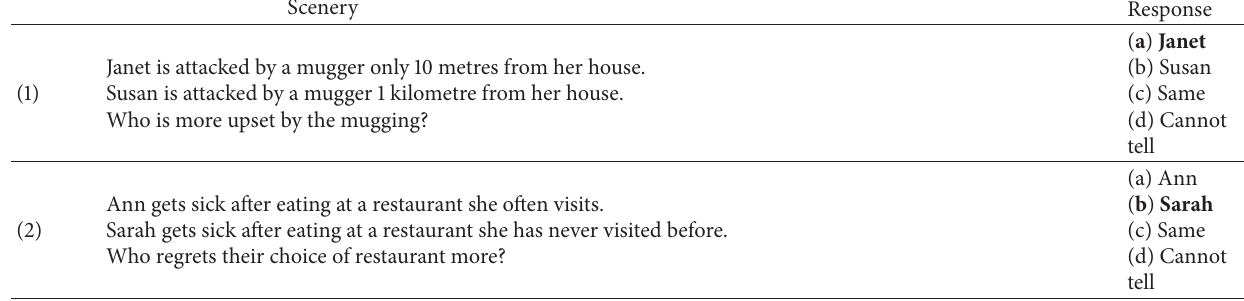
Table 3: The counterfactual interference test (Hooker et al. 2003 [27]). Scenery